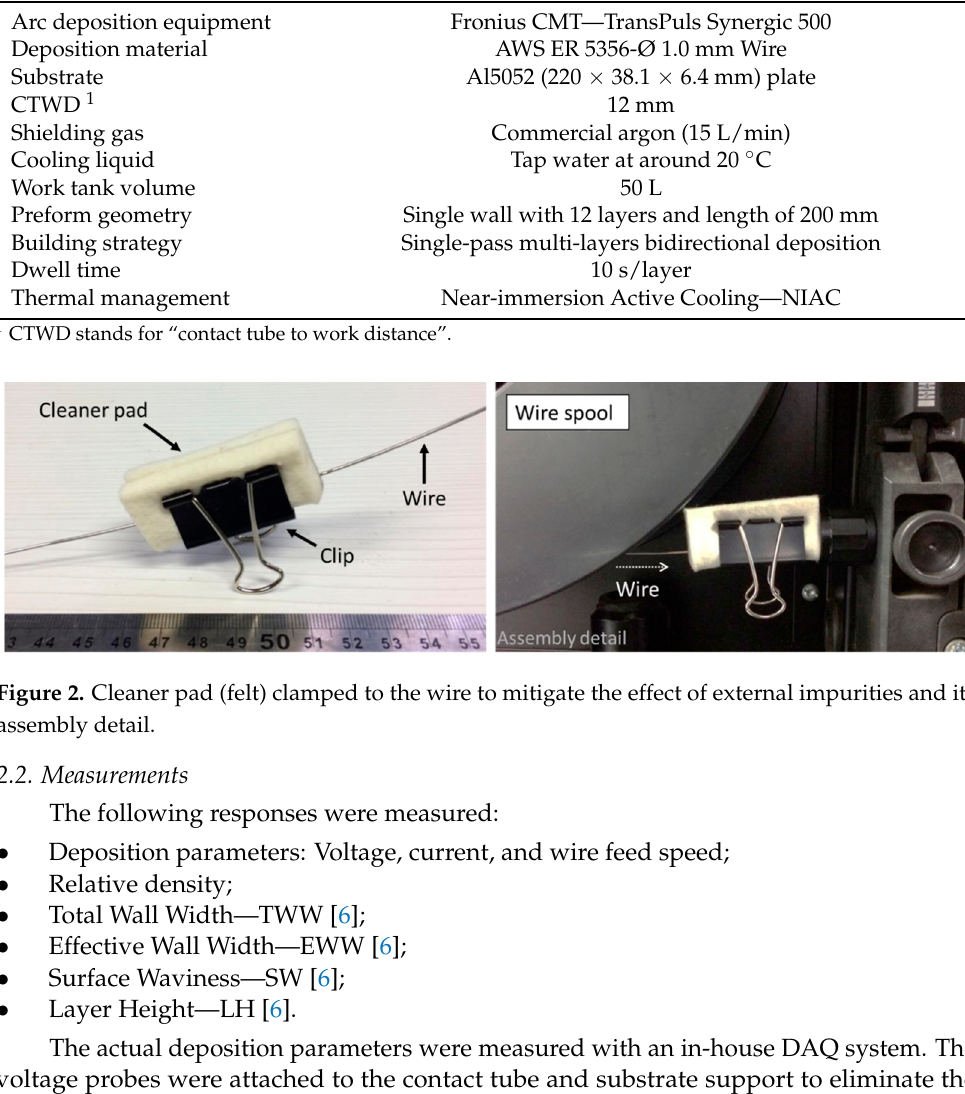
Table 2. Deposition conditions for the parameter selection procedure.